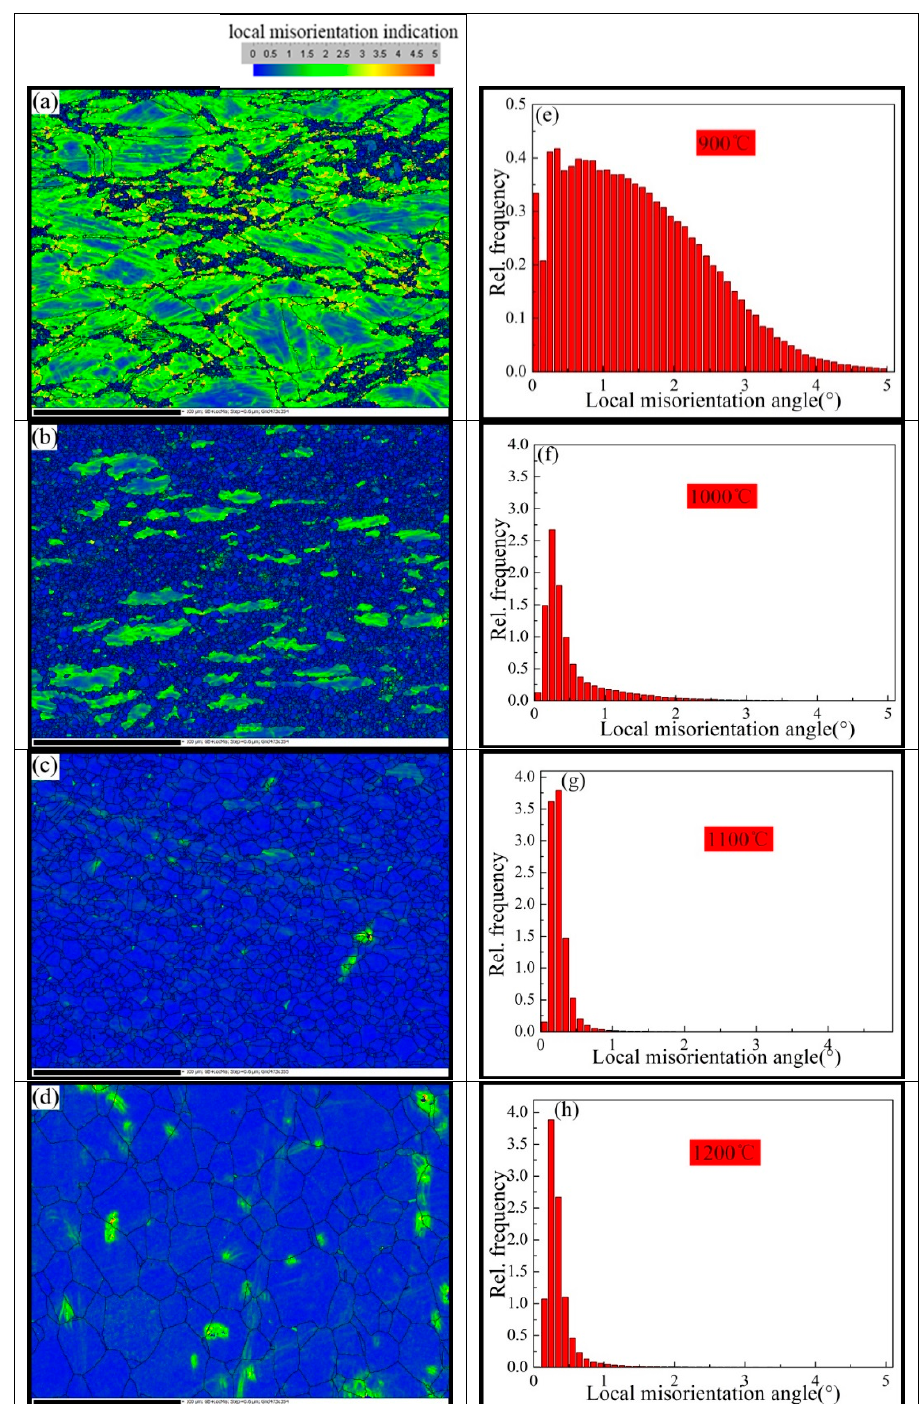
Figure 12. Kernel average misorientation (KAM) maps and local misorientation angles at different temperatures. ( a,e ) 900 °C; ( b,f ) 1000 °C; ( c,g ) 1100 °C; ( d , h ) 1200 °C.